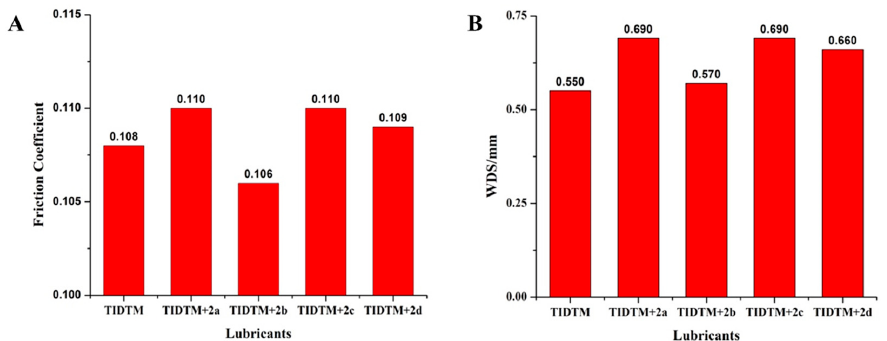
Figure 3. Friction coefficient ( A ); and wear scar diameter ( B ) under the lubrication of TIDTM and TIDTM containing 1 wt % 2a – d , respectively.